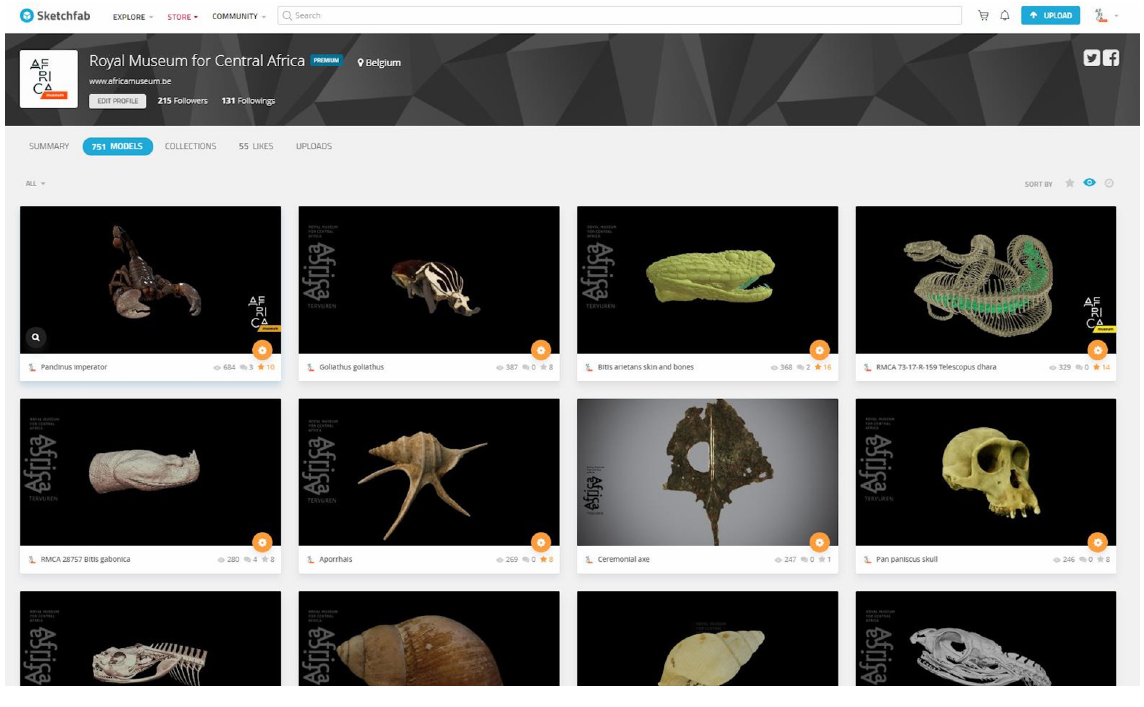
Fig. 8.1. Sketchfab page of